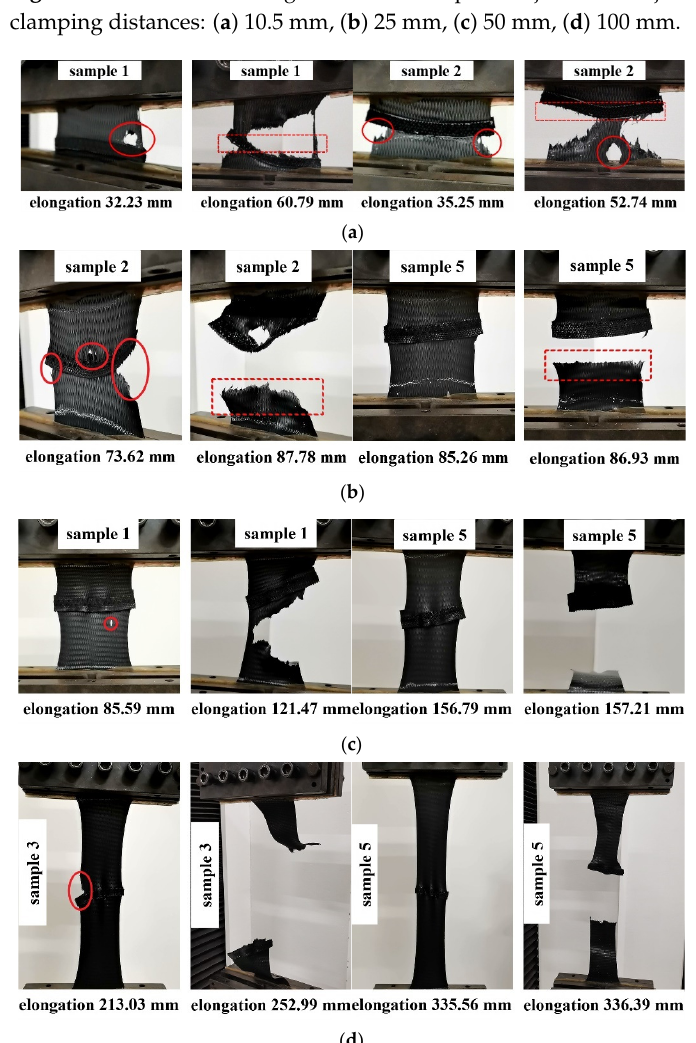
Figure 12. Failure modes of the junction subjected to shear force under various clamping distances: ( a ) 10.5 mm, ( b ) 25 mm, ( c ) 50 mm, ( d ) 100 mm.